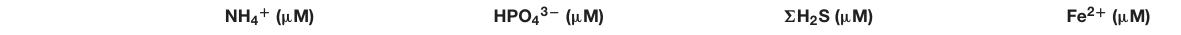
TABLE 2 | Pore water solute data obtained from Big Egg and JoCo marshes, Jamaica Bay,